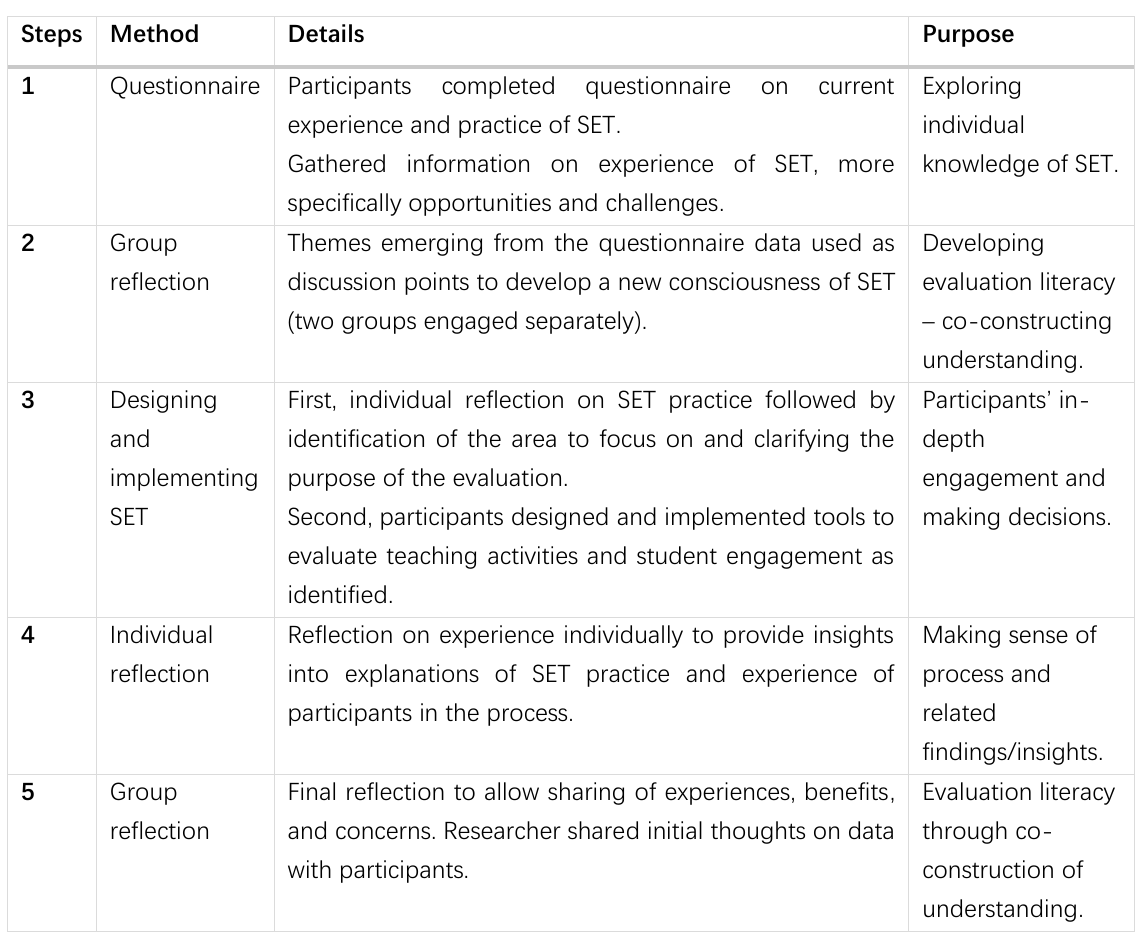
Table 2 : The five steps of the research process